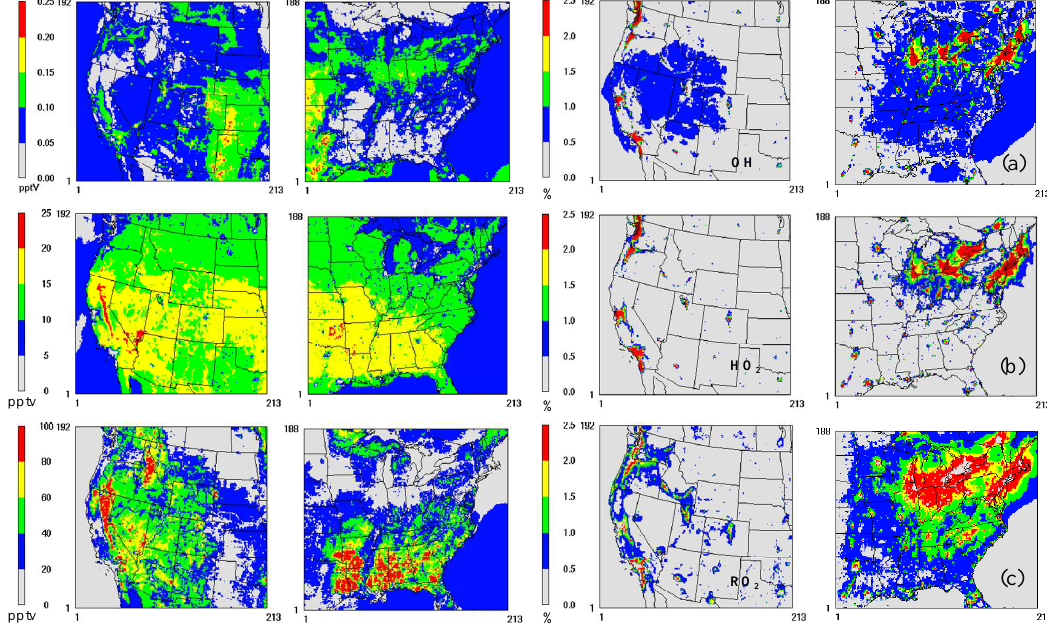
Fig. 3. (a) Monthly mean OH with CB05-Base and percent increases in mean OH between CB05-TU and CB05-Base (b) mean HO 2 with CB05-Base and percent increases in mean HO 2 between CB05-TU and CB05-Base (c) mean RO 2 with CB05-Base and percent increases in Figure 4: (a) monthly mean (daytime) NO z with CB05-Base (b) percent increases in mean NO z mean RO 2 between CB05-TU and CB05-Base. In each row, the first two plots represent mean values (pptv) and the last two plots represent between CB05-TU and CB05-Base percent changes (%).